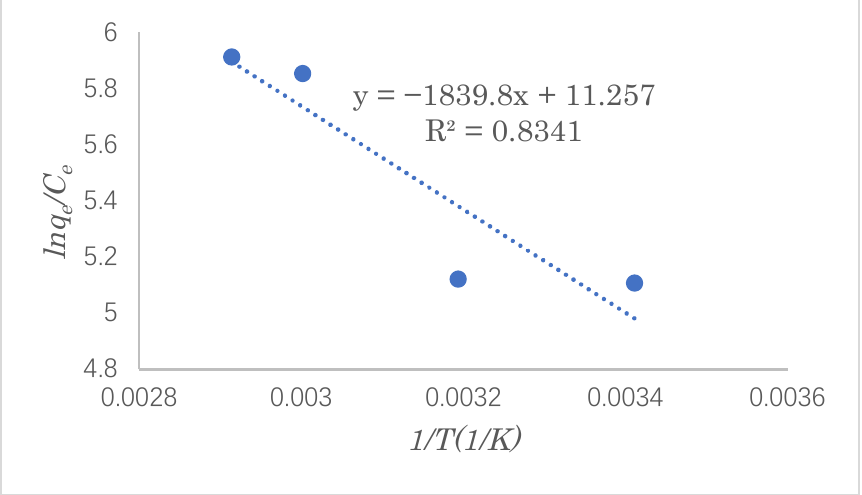
(cid:3044) (cid:3280) Figure 15. Plot of (cid:1864)(cid:1866) and 1 /T for estimation of the thermodynamic parameters obtained for the Figure 15. Plot of ln q e and 1/ T for estimation of the thermodynamic parameters obtained for the C e (cid:3004) (cid:3280) adsorption of SDS by modified adsorption of SDS by modified cellulose. Table 4. Thermodynamic parameters for the adsorption of SDS by modified cellulose.